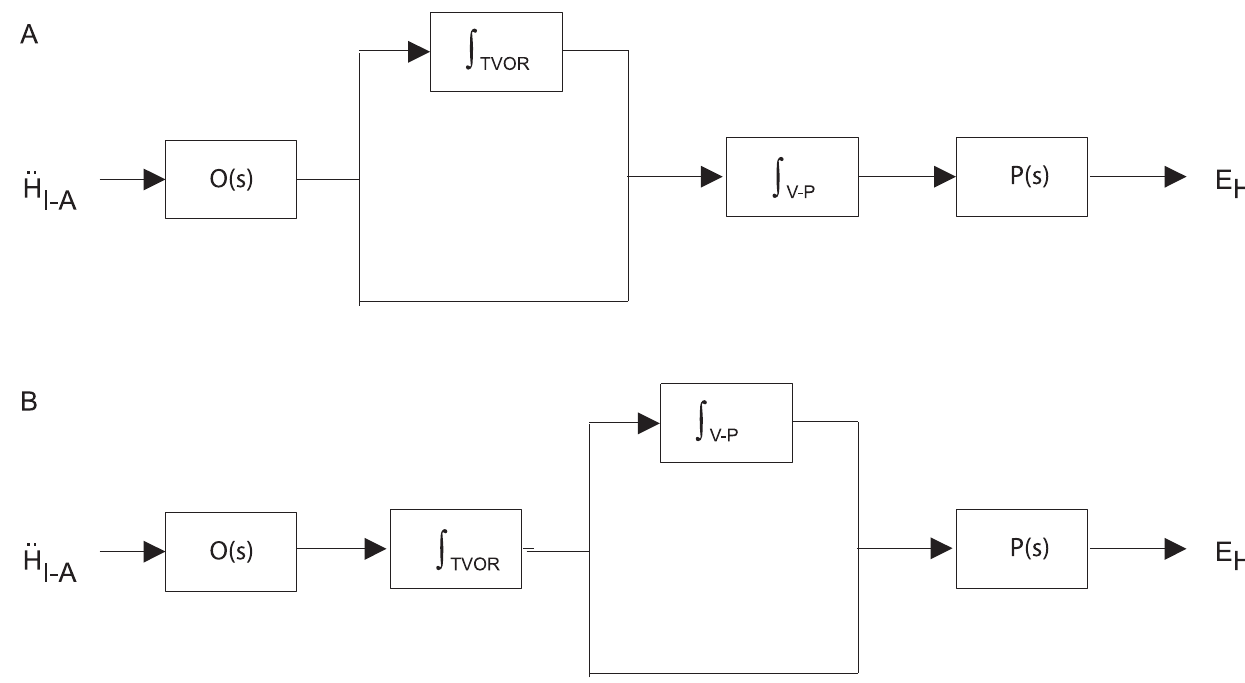
Figure 9. Comparison of basic model structure proposed here (a) with that suggested by Green and Angelaki [ 46 ] , shown in b. a . In our model, the tVOR integrator is placed in parallel with a direct projection; the integrator is responsible for the component of eye velocity that is proportional to head-velocity, and the direct pathway provides the component that is proportional to head acceleration. The gain of the tVOR integrator is reduced by the Nod/Uv lesions, whereas the gain of the direct pathway is little affected. b . In the Green and Angelaki model, the direct pathway parallels the common integrator, formulated as the ‘‘plant compensator.’’ The tVOR integrator is incorporated into a ‘‘pre-filtering’’ stage. This model could not easily explain our post-lesion data. If the gain of the tVOR integrator were reduced, then both the velocity- and acceleration- dependent components of the response would be equally affected. On the other hand, reducing the gain of the common integrator could selectively alter the velocity-dependent component, but this would also cause pulse-step mismatch of saccades. It is unlikely that both integrators have a parallel direct pathway, because this would give eye velocity a component that is proportional to head jerk.